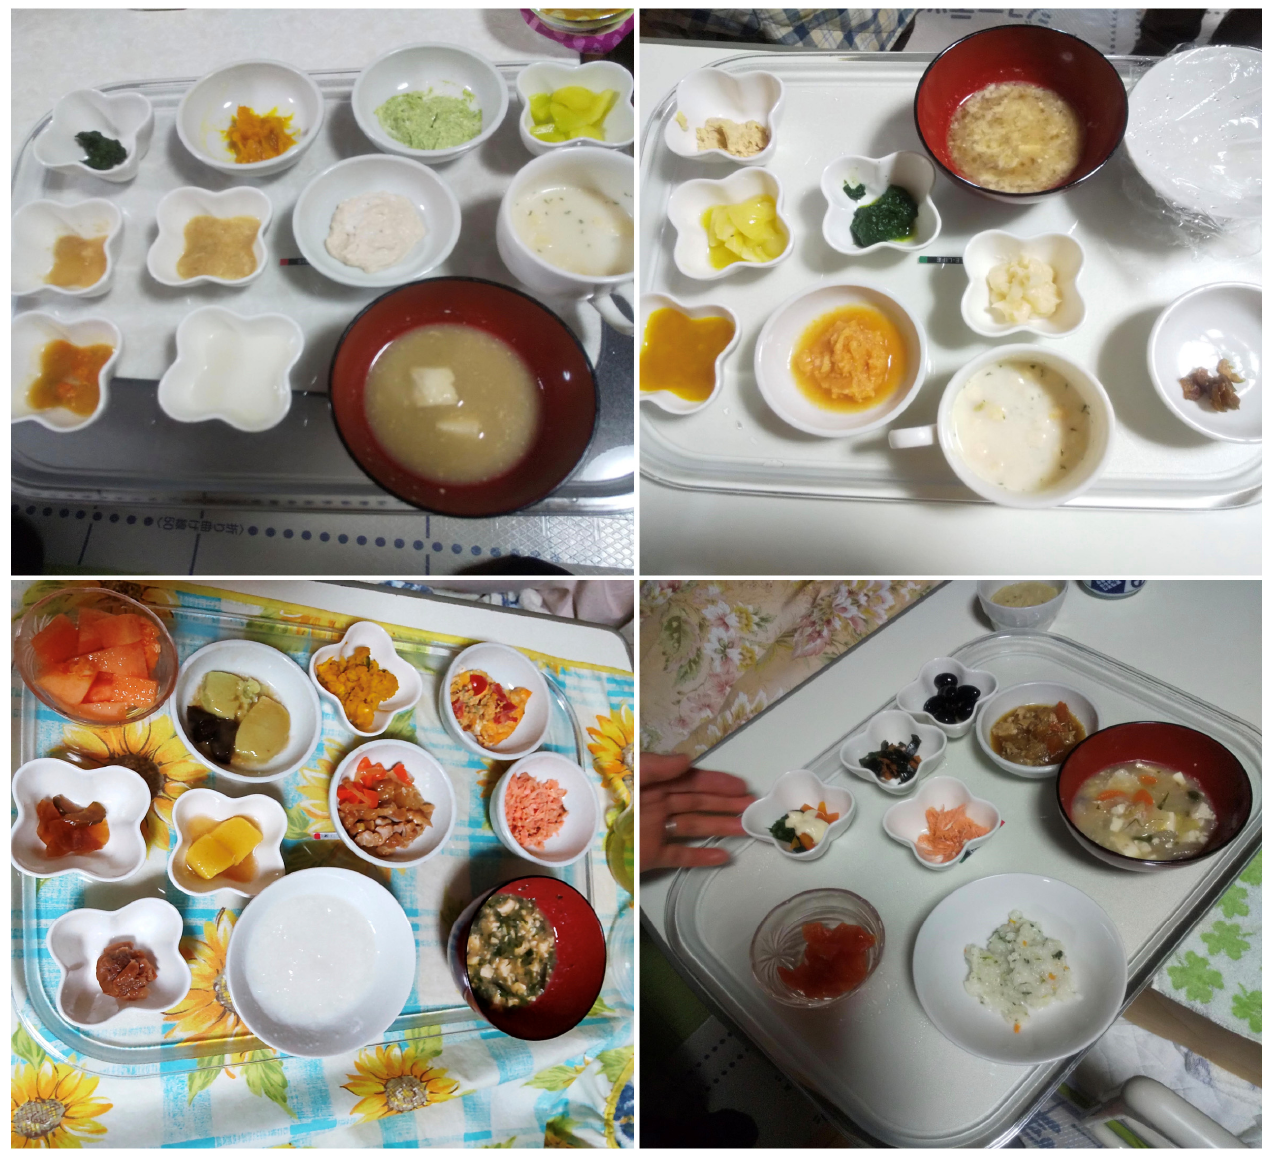
Figure 3. Side view ( left ), neck region ( middle ), and foot region ( right ) of the patient after postural regulation.